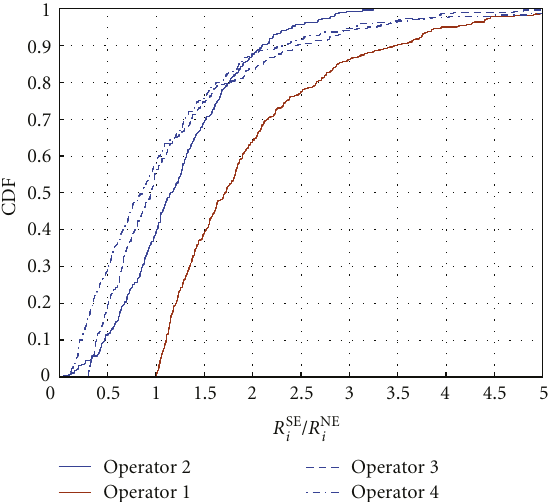
Figure 10: Cumulative distribution function (CDF) of the ratio of the rates between the hierarchical (Stackelberg) and noncooperative for operator i , i = (selfish) approaches R SE /R NE i i